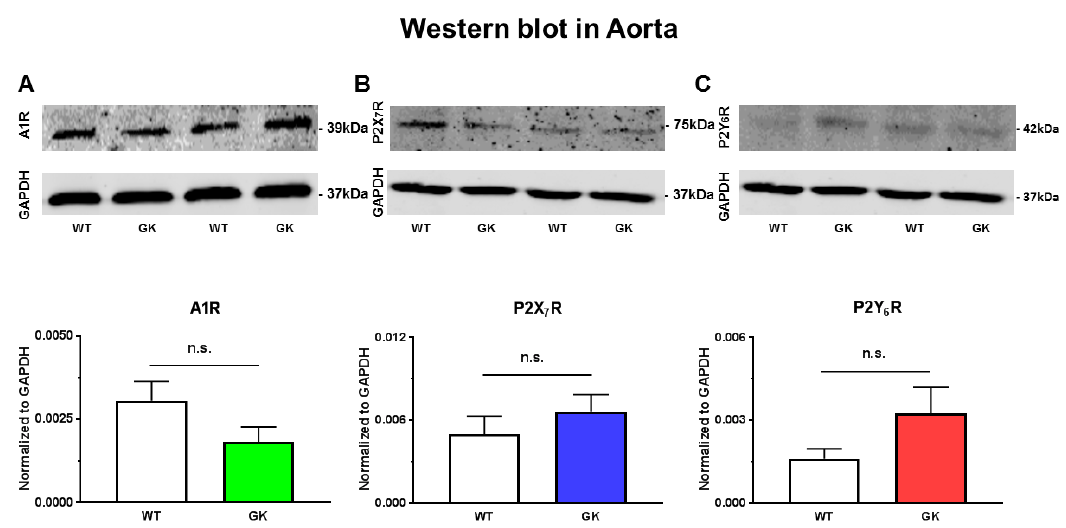
Figure 8. Protein expression of the A1R ( A ), P2X 7 R ( B ), and P2Y 6 R ( C ) in aortas from WT ( n = 6) and GK rats ( n = 8). Data are presented as mean ± SEM; n.s: not statistically significant with unpaired Student’s t -test.